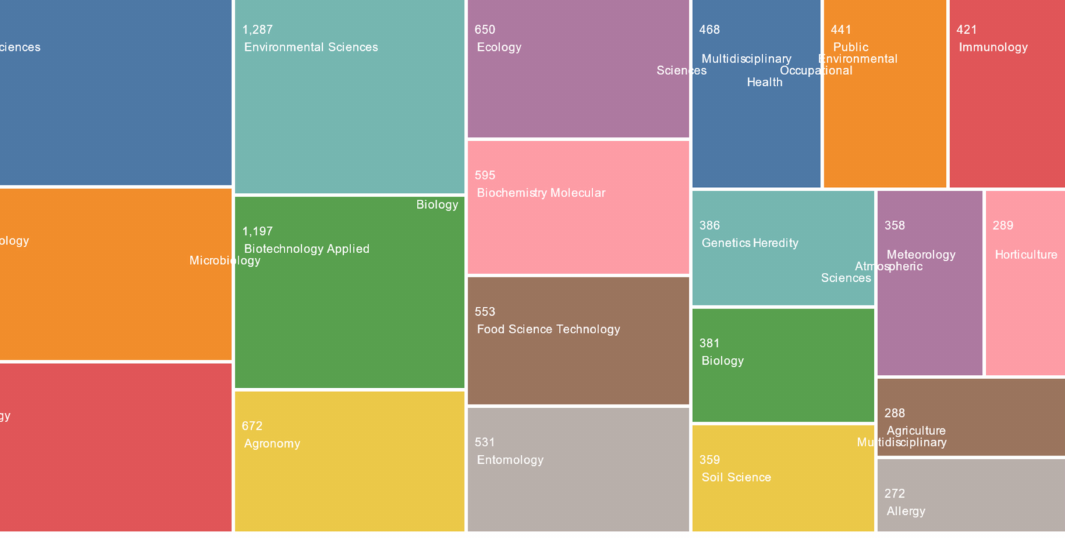
Figure 2. Categories of the published articles with the theme “fungal spores” (Source Web of knowledge, December 2021).